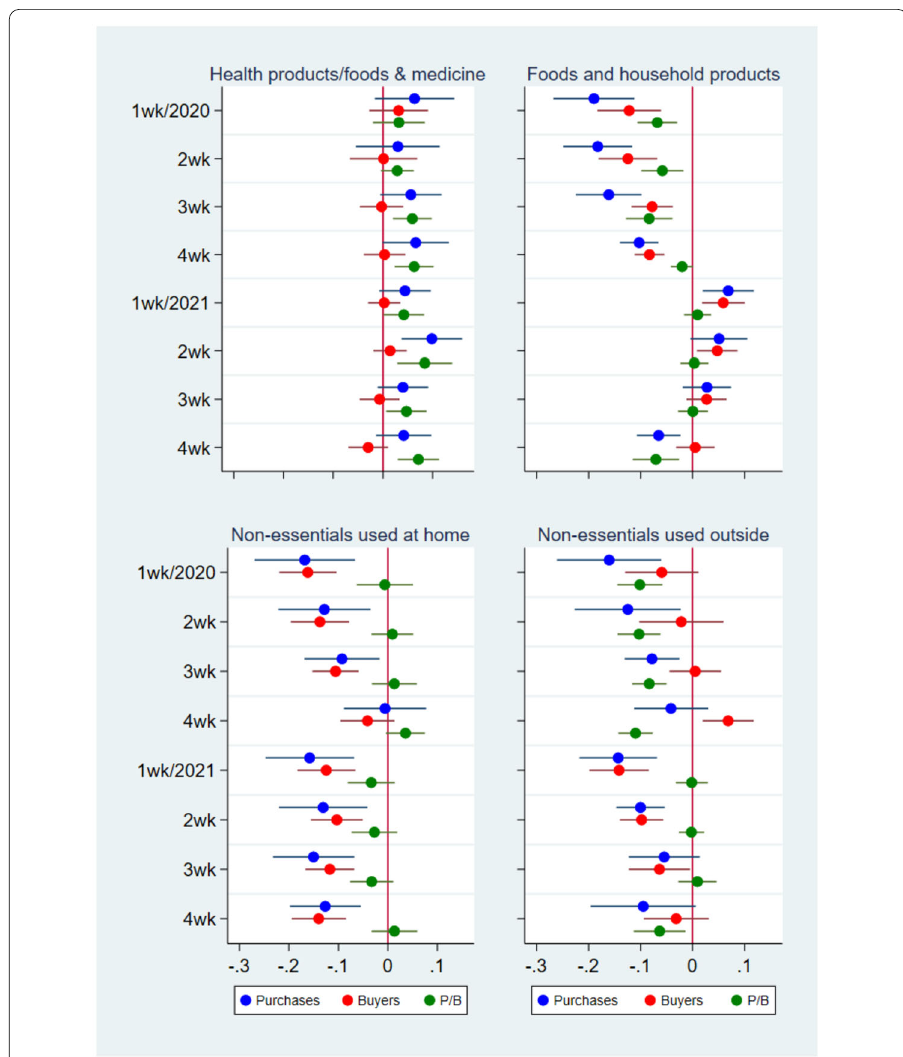
Figure 11 Posttreatment Effects of a State of Emergency on the Purchase Amount Purchases, the Number of Buyers, and the Purchase Amount per Buyer by Product Category. This figure illustrates the results from the regressions of the purchase amount, the number of buyers, and the purchase amount per buyer in logs at the prefecture–product–date level by the product category. The dots and lines indicate the coefficients and 95% confidence intervals of the effect of the dummies for 1-4 weeks after a state of emergency (SoE) in different months on the purchase amount (blue), the number of buyers (red), and the purchase amount per buyer (green). “1wk/2020” on the x-axis means 1 week after an SoE in 2020. In all the regressions, the other independent variables are the dummies for an SoE; the dummies for before an SoE; the number of COVID-19 cases per 1000 persons; the number of neighboring prefectures in an SoE; and the prefecture, product, date, and day-of-the-week fixed effects. The standard errors are clustered at the prefecture and date levels. N